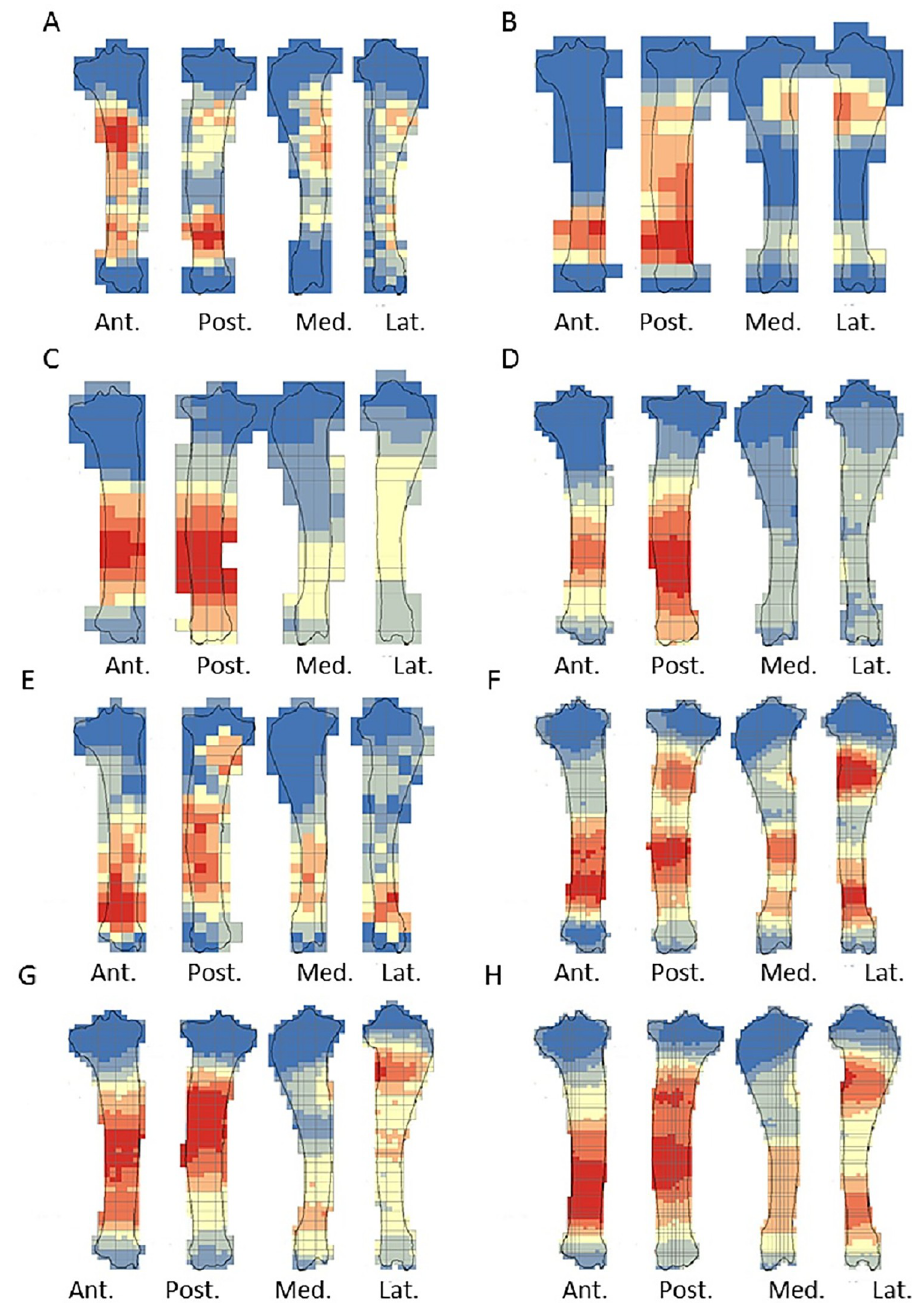
Fig 12. Optimized hot spot analysis of combined percussion marks from the tibias in each series. A-E- Individual n˚4; B-F- Individual n˚6; C-G- Individual n˚10; D-H- Merged tibias series; A, B, C and D: “CNA” Percussion marks and E, F, G and H: pits and grooves (Ind.: